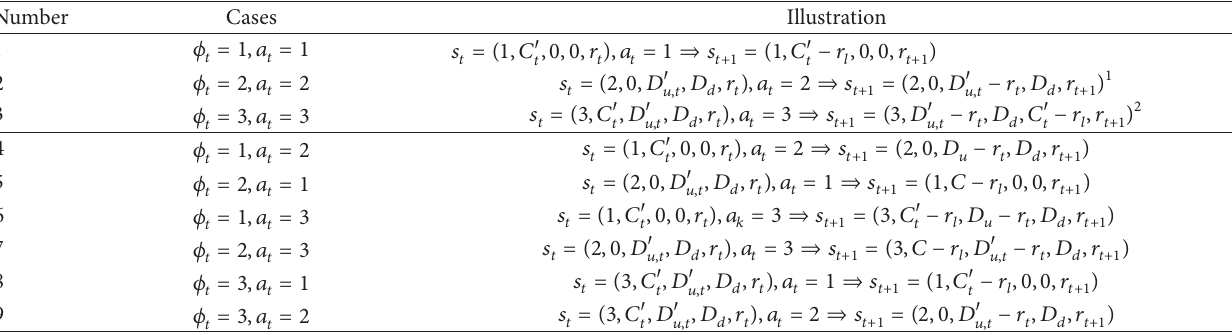
Table 2: Actions and states